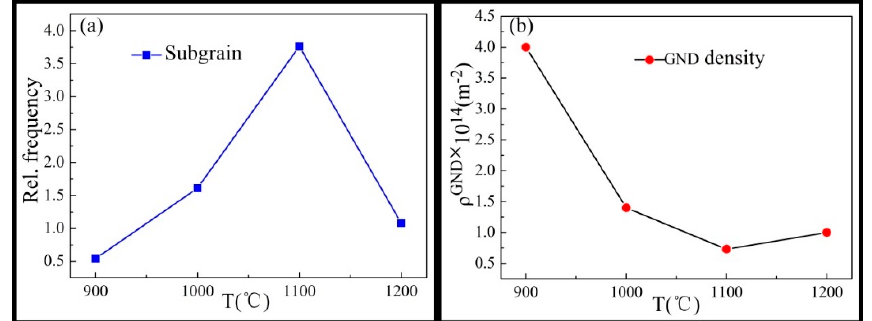
Figure 13. The frequencies of subgrains and geometrically necessary dislocation ( GND ) densities measured at different temperatures. ( a ) The frequencies of subgrains; ( b ) GND densities